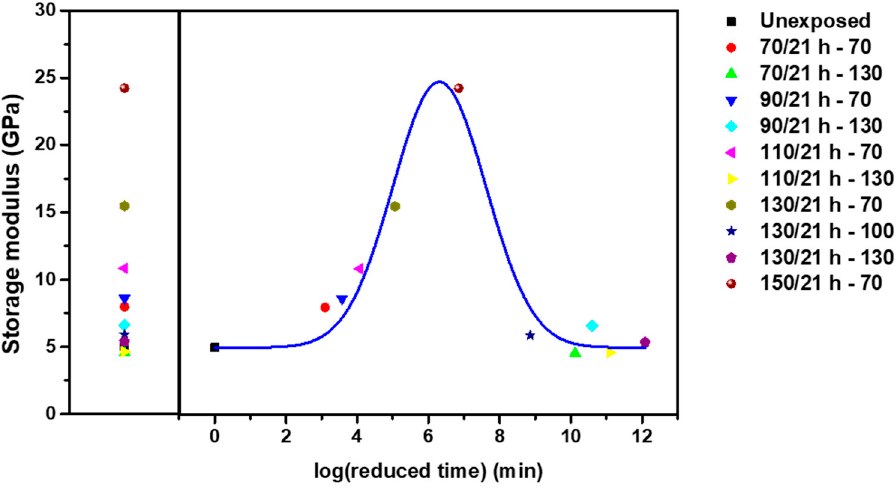
Figure 8. Long-term variation in the storage modulus of CF-SMPCs when maintained at 70 °C under a LEO environment. Legends for each data point represent the LEO-exposure conditions. The original data were subjected to shift operations.